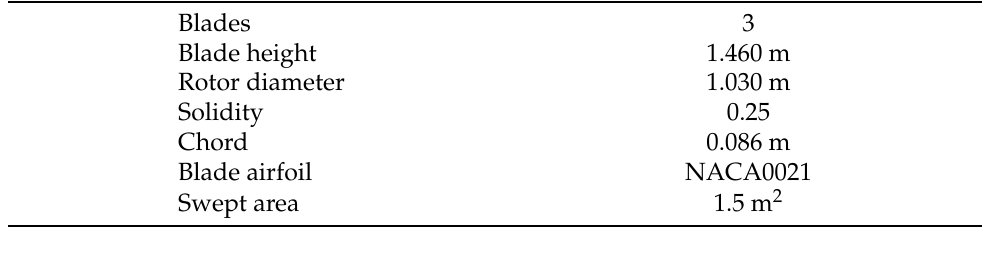
Table 2. Troposkein geometric